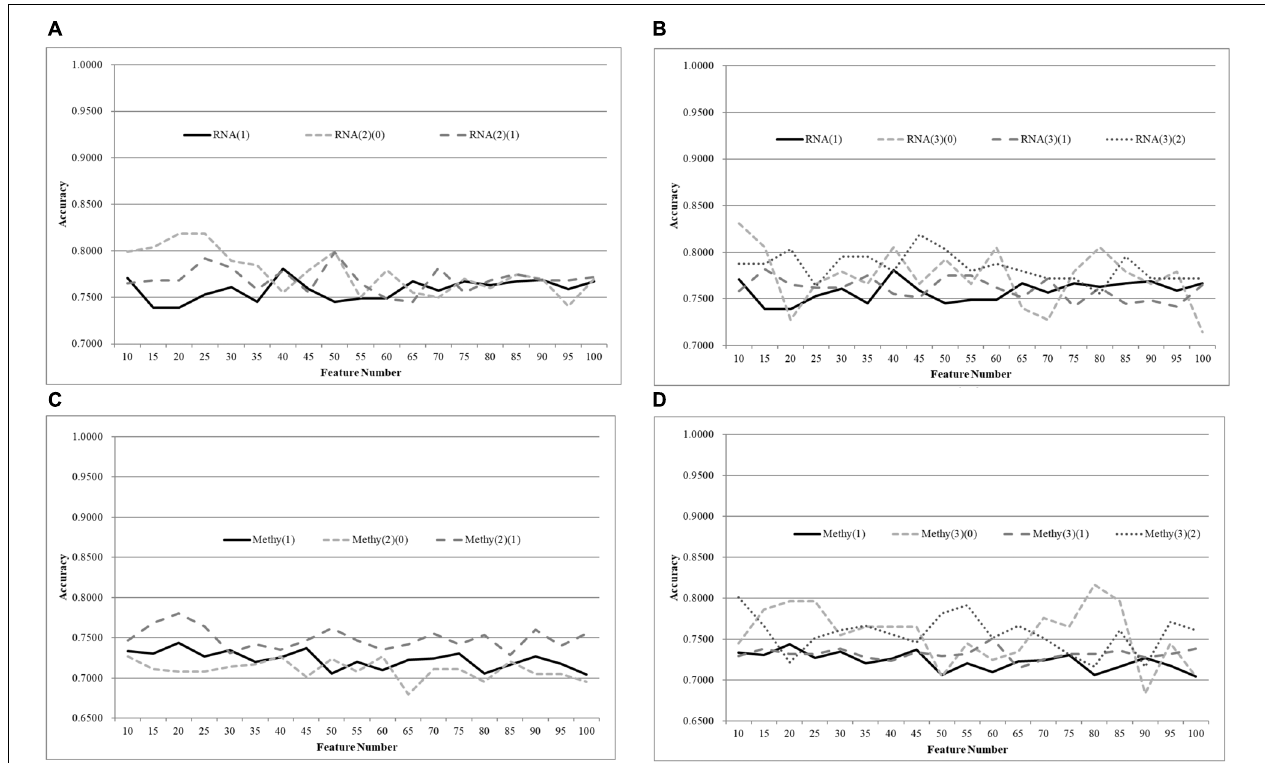
FIGURE 6 | Comparison of early-stage breast cancer detection models with different age groups based on both transcriptome and methylome data. Transcriptomes of the patients were split into (A) two groups and (B) three groups with equally-sized age ranges. The methylomes were split into (C) two groups and (D) three groups in the same way. The horizontal axis shows the numbers of features chosen by TriVote and the vertical axis shows the 10-fold cross-validation accuracy of the classifier RFC. F -test was used to generate the initial subset of the 1000 top-ranked features.